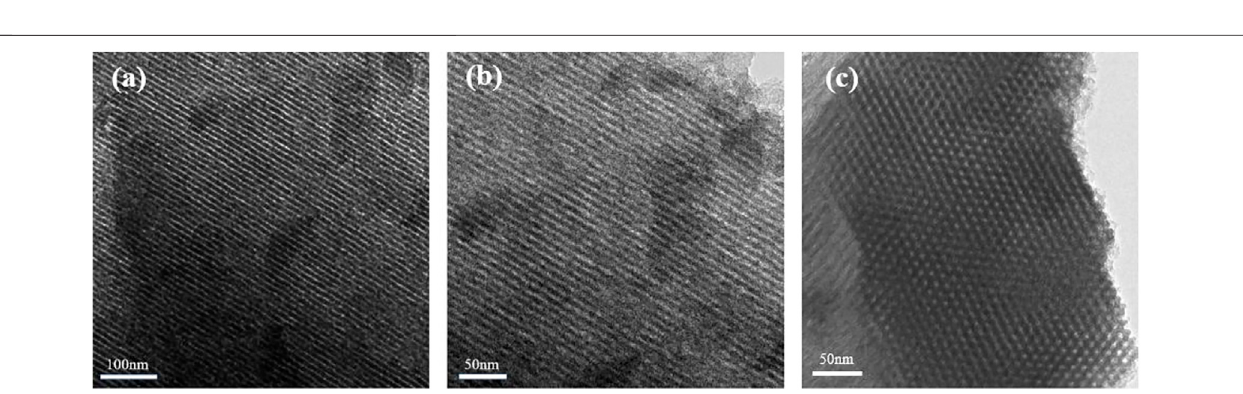
FIGURE 2 | TEM images of HPCs synthesized with HISA method in the F127/ethanol system.